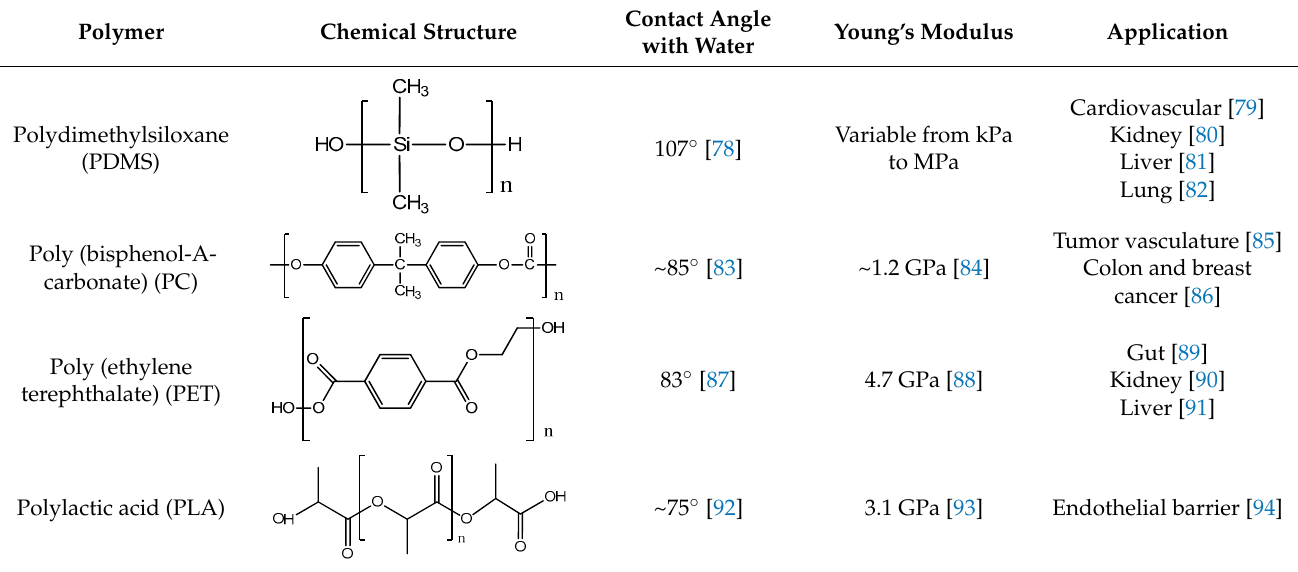
Table 2. The main polymers employed in the fabrication of membranes in OOCs microdevices. Polymer